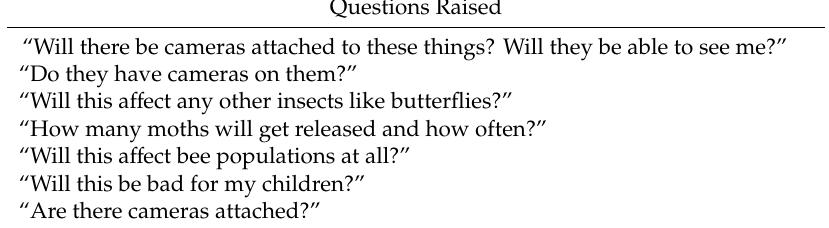
Table 1. Questions raised by the community as a response to the proposed unmanned aerial